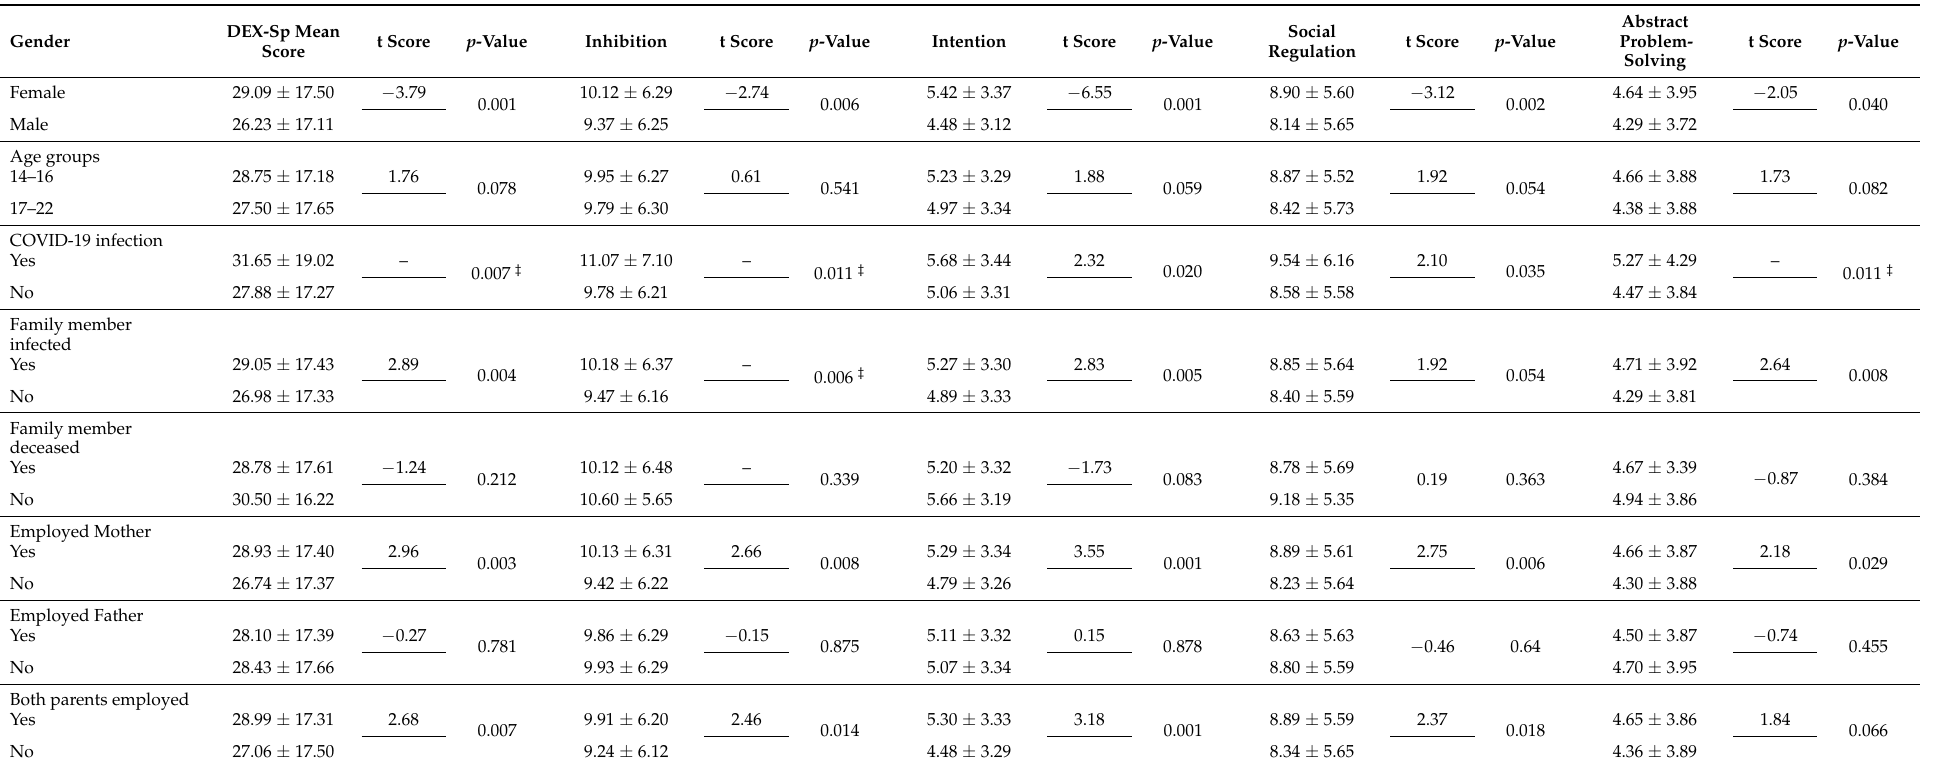
Table 2. DEX-Sp scale and subscales scores distribution between